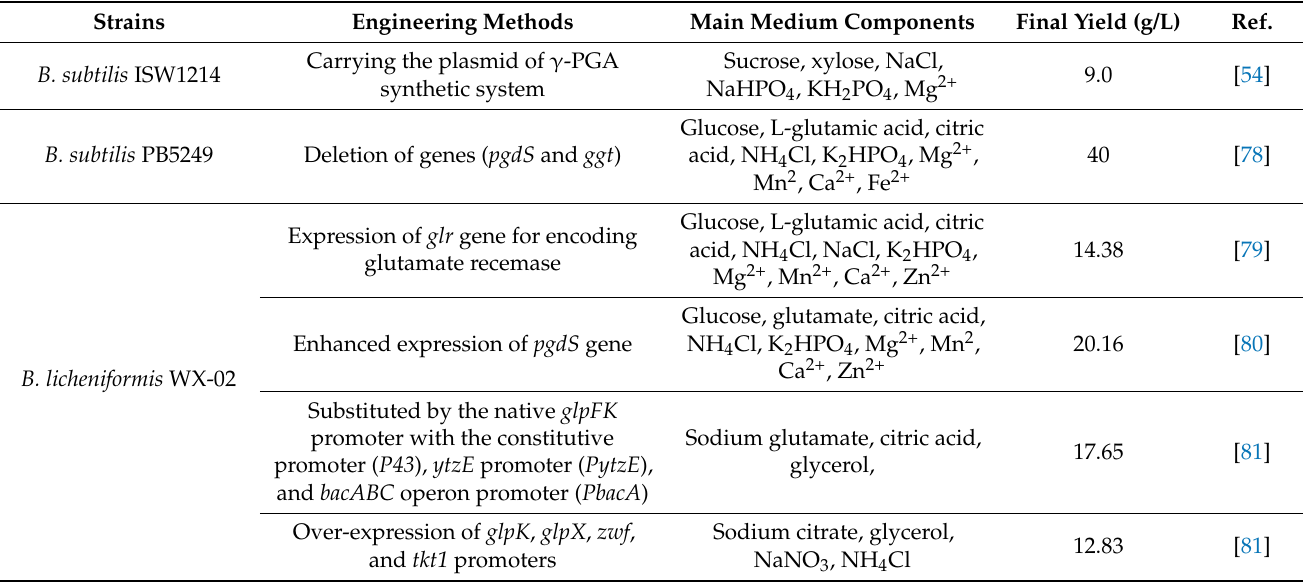
Table 2. Genetic manipulations of γ